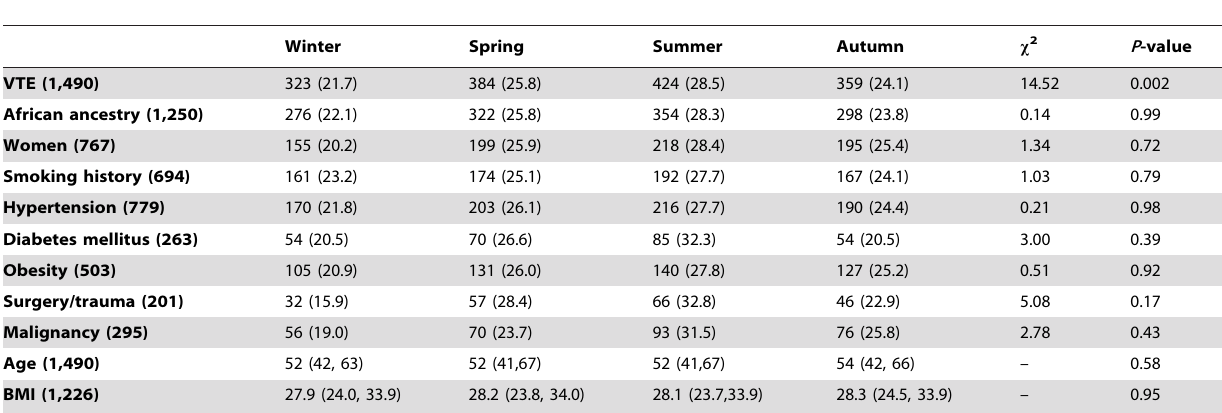
Table 2. Seasonal distribution of venous thromboembolism in Detroit as a function of potential risk